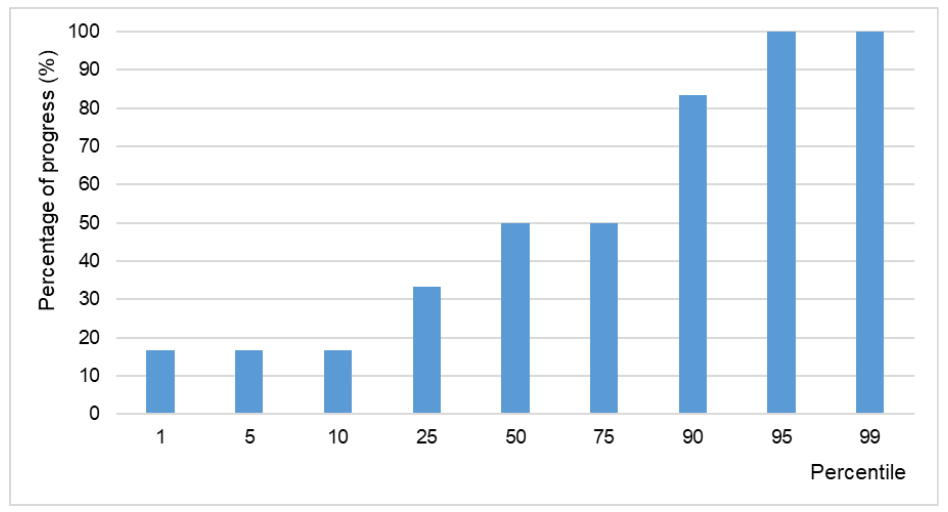
Figure 4. Percentage of students’ progress in the educational material for the Agricultural Residues MOOC.